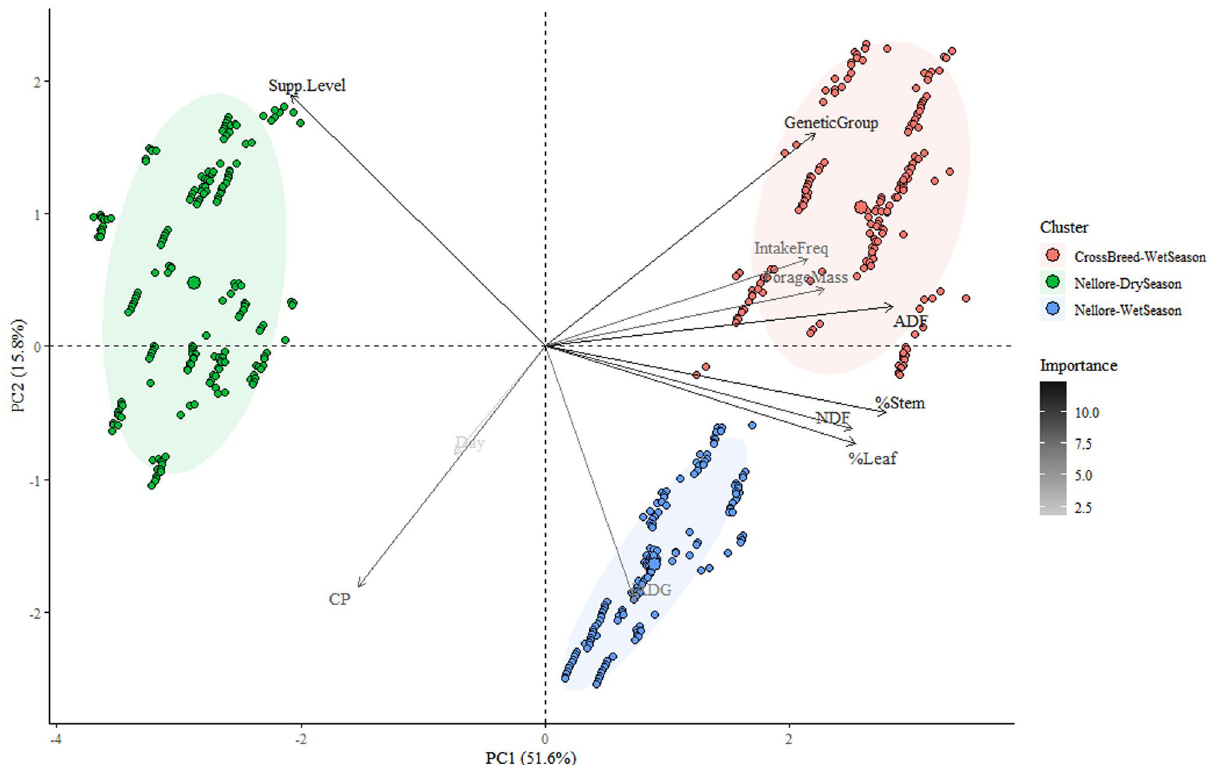
Figure 2. Principal component analysis on the final responses according to their importance for forecasting animal performance and food intake frequency, using a Random Forest method. iADG, intermediate average daily gain; NDF, neutral detergent fiber; ADF, acid detergent fiber; CP, crude protein; PC1, principal component one; PC2, principal component